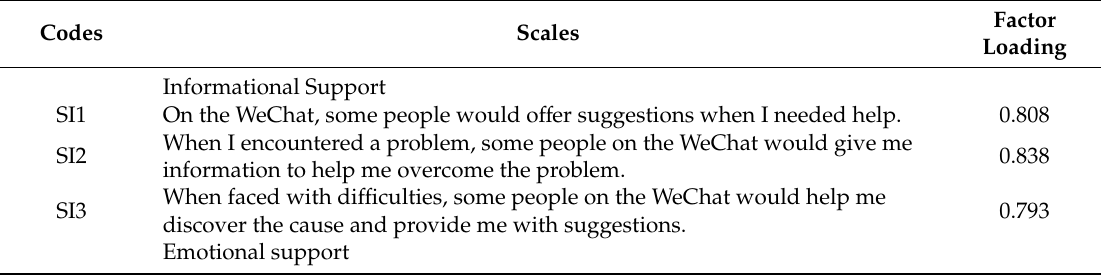
Table 1. Factor loading of